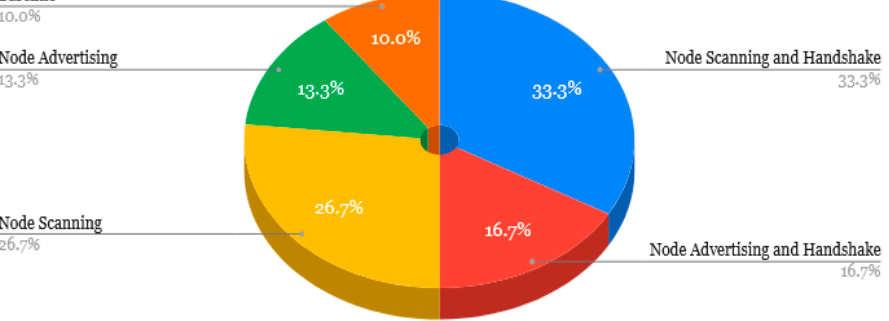
Figure 4. Power consumption in cryptographically aware modes.